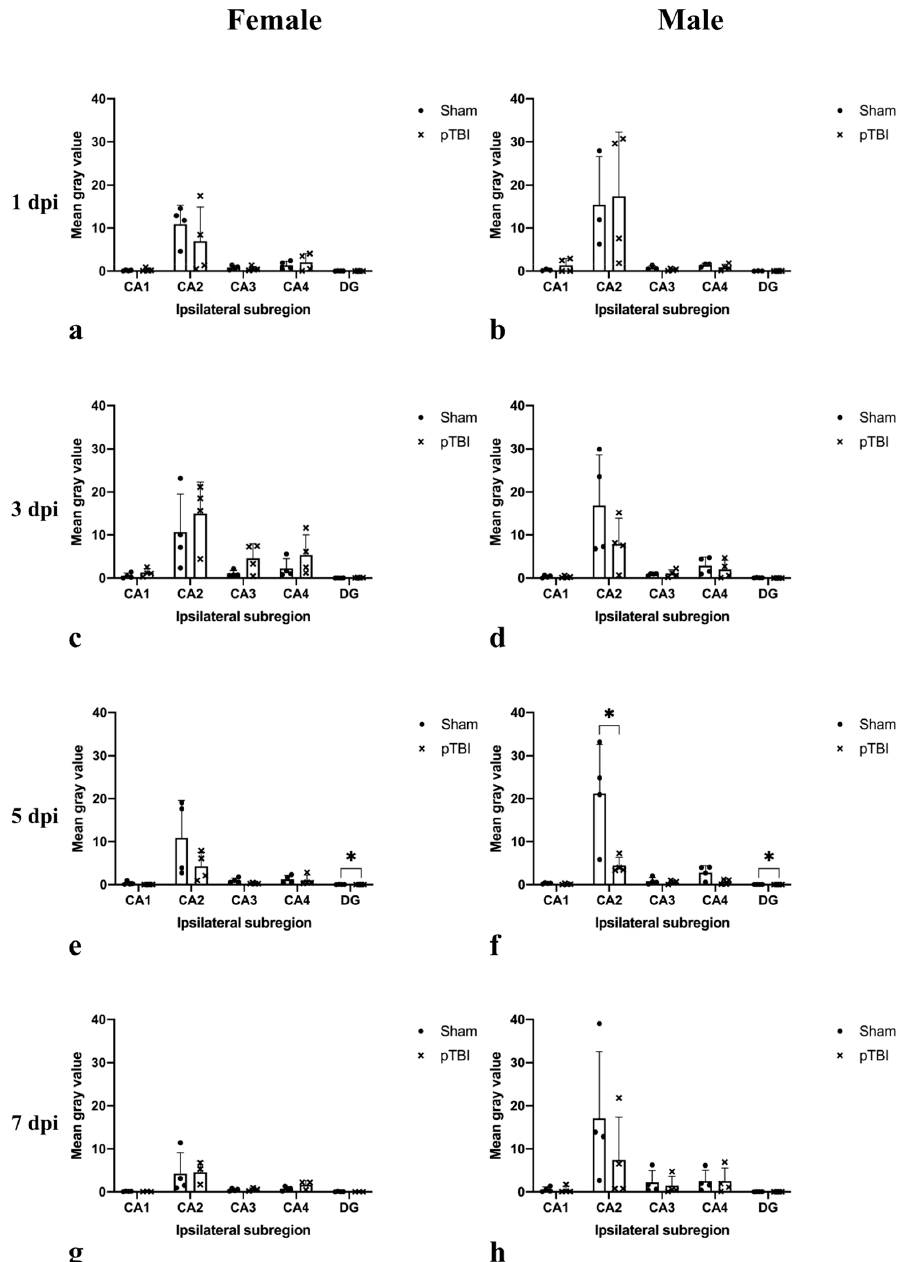
Figure 2. Comparison of hippocampal CYP1B1 mRNA expression detected by in situ hybridization in rats subjected to either sham-surgery or pTBI. Animals in Sham received a craniotomy, while animals in pTBI received a craniotomy with a subsequent pTBI. CYP1B1 mRNA was detected by in situ hybridization. Comparisons between Sham and pTBI were performed in animals with the same sex and survival time. Graphs show female mRNA expression 1 dpi ( a ), male mRNA expression 1 dpi ( b ), female mRNA expression 3 dpi ( c ), male mRNA expression 3 dpi ( d ), female mRNA expression 5 dpi ( e ), male mRNA expression 5 dpi ( f ), female mRNA expression 7 dpi ( g ), male mRNA expression 7 dpi ( h ). The mean gray value is presented in the Y-axis, showing the average mean gray value calculated from each measured cell for each subregion. To calculate mean gray value, images were made binary and in-situ probes made black and separated from the white background. The gray value of the color black was set to 255 and the value for white to 0. The gray value of each cell is therefore a measurement of the area of cell marked by the in-situ probe. The gray values from each cell of each subregion were then used to calculate the mean gray value of each subregion and